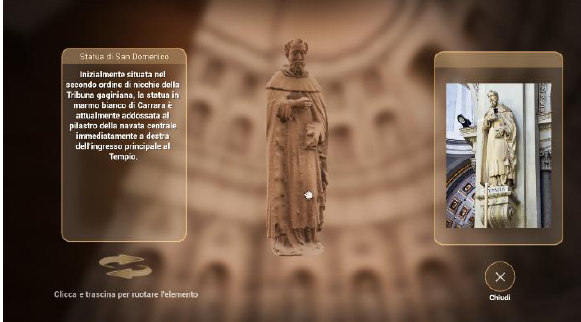
Figure 12: Unreal Engine, analysis interface of the inspectable